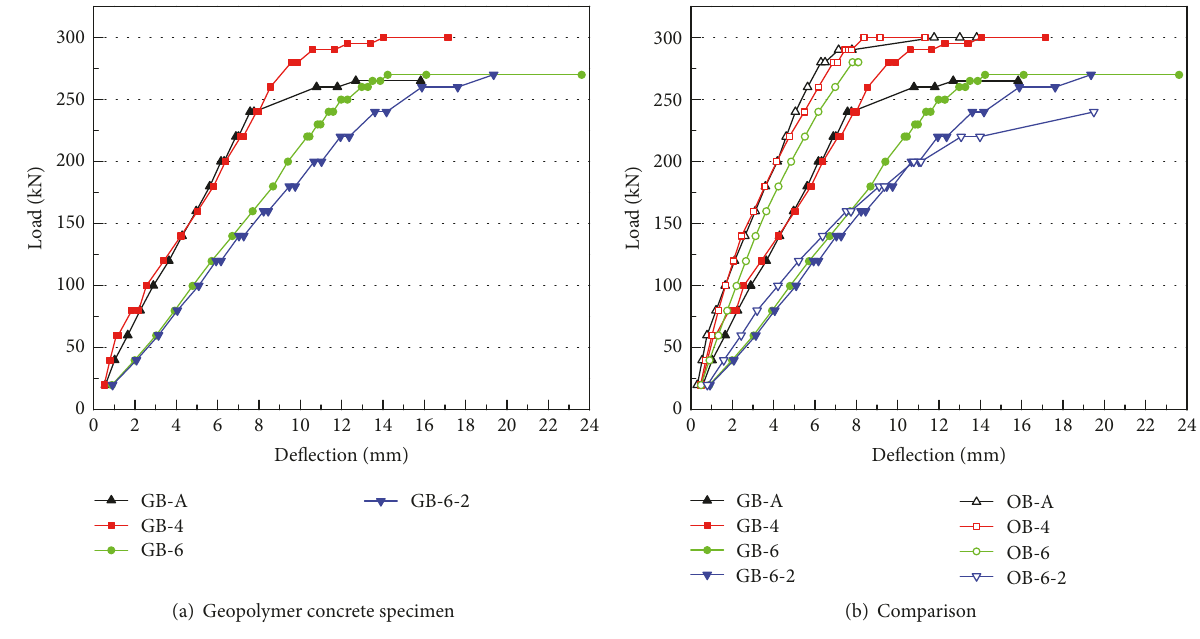
Figure 5: Load-deflection curves.